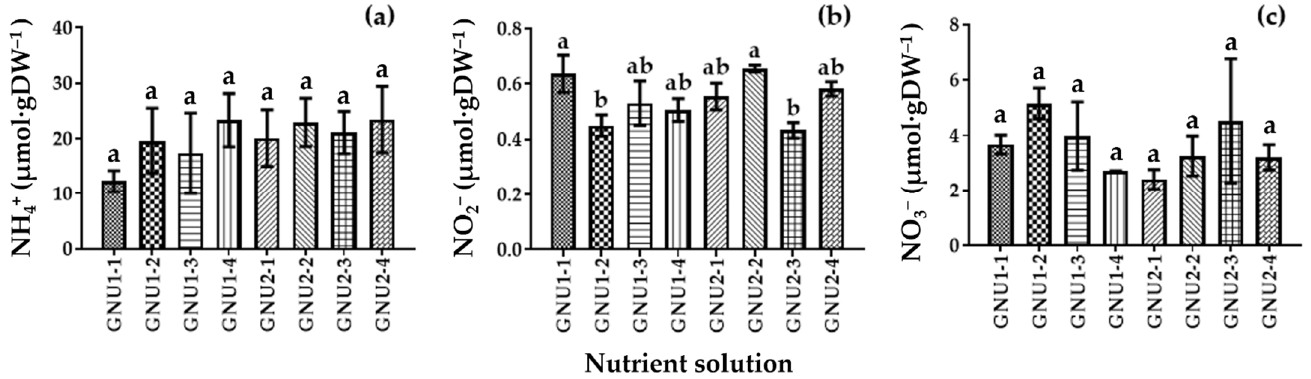
Figure 9. Tissue contents of NH 4+ ( a ), NO 2 − ( b ), and NO 3 − ( c ) as affected by the nutrient solution in Experiment 2. Vertical bars represent the SEs of three biological replicates ( n = 3). Significant differences among treatments are indicated by lowercase letters at p ≤ 0.05 according to Duncan’s multiple range test.